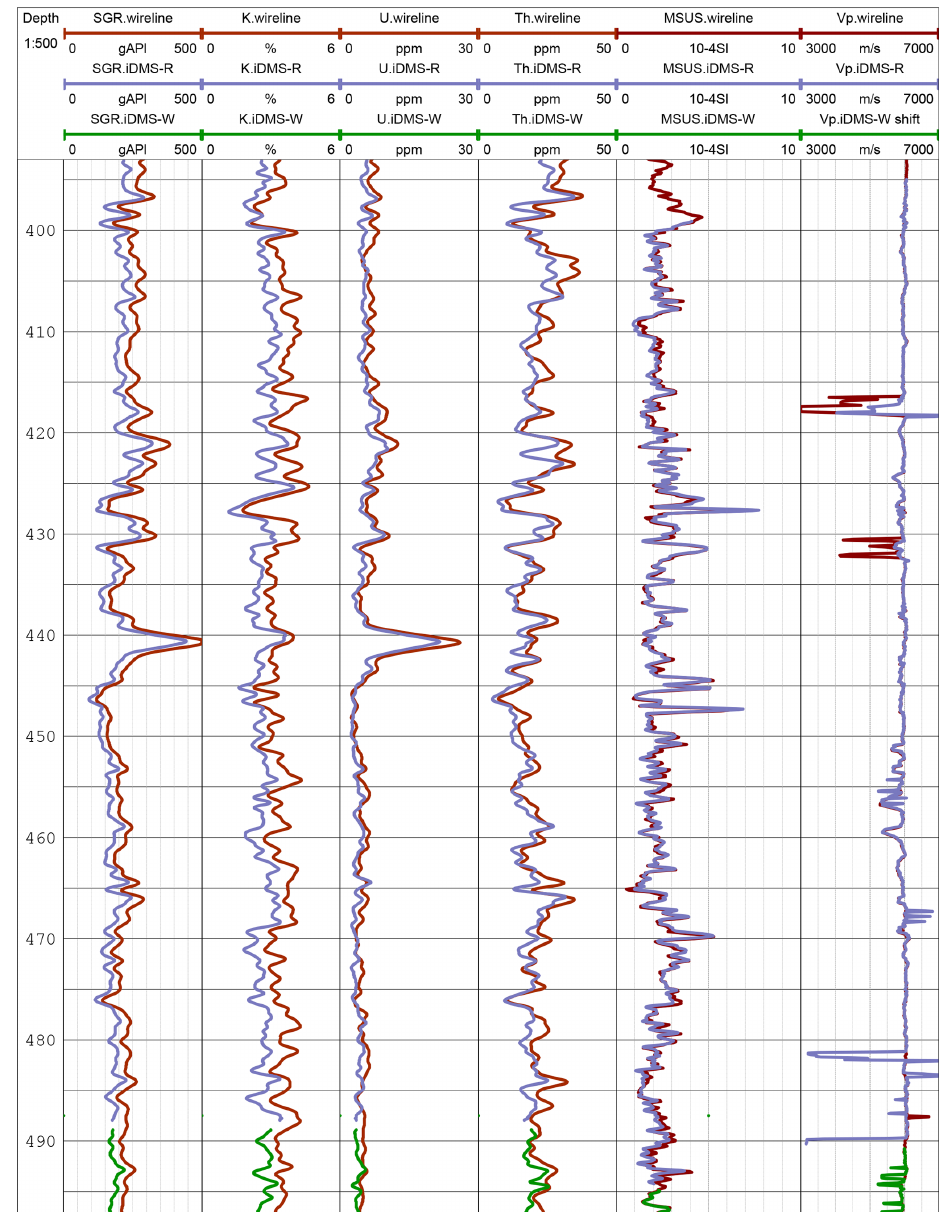
Figure 5. Depth (in meters) comparison of iMLS logging data from the wireline mode run (brown) and the memory mode run with two independent depth devices (green represents the iDMD-W prototype, and blue represents the iDMD-R) in the TC1 well, Örebro, Sweden. Depth differences between the wireline and memory mode are less than 0.1m. Here, SGR denotes the parameter total gamma ray measured by the spectrum GR tool, and K, U, and Th are the contents of potassium, uranium, and thorium, respectively. All mSGR-derived curves are corrected for the effects of borehole size and steel casing. MSUS is the magnetic susceptibility, and Vp is the sonic P-wave